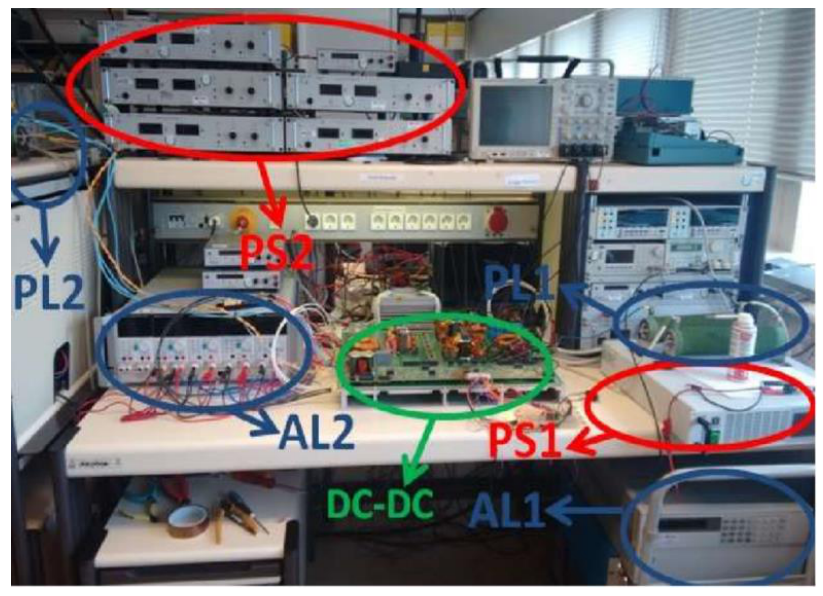
Figure 13. The arranged test setup.